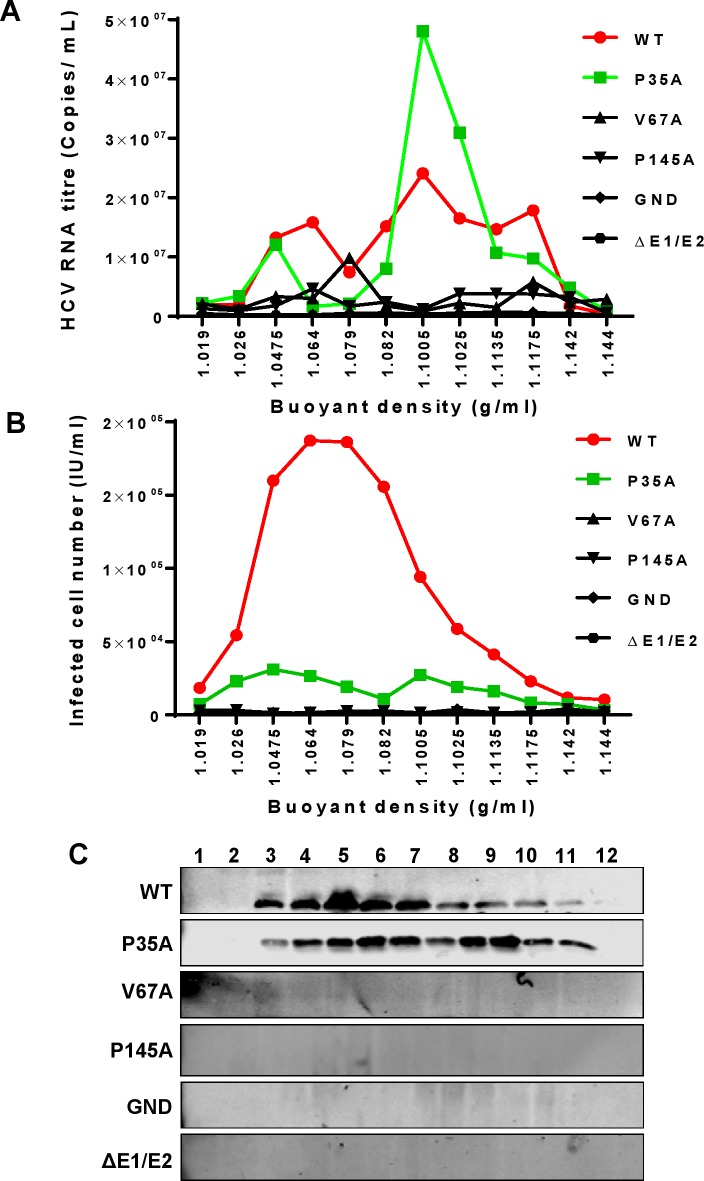
Density gradient analysis of mutant viruses.Huh7.5 cells were electroporated with in vitro transcripts of WT or the indicated virus mutants. Concentrated culture medium was fractionated using 10–40% iodixanol density-gradient centrifugation. For each fraction, HCV RNA (A) and infectivity (B) were plotted against the buoyant density (n = 3), and Core protein in each fraction was detected by western blot (C). 1 to 12 in (C) indicated the fractions collected from top to bottom with the buoyant density indicated in (A) and (B). The result of a representative of three independent experiments is shown.